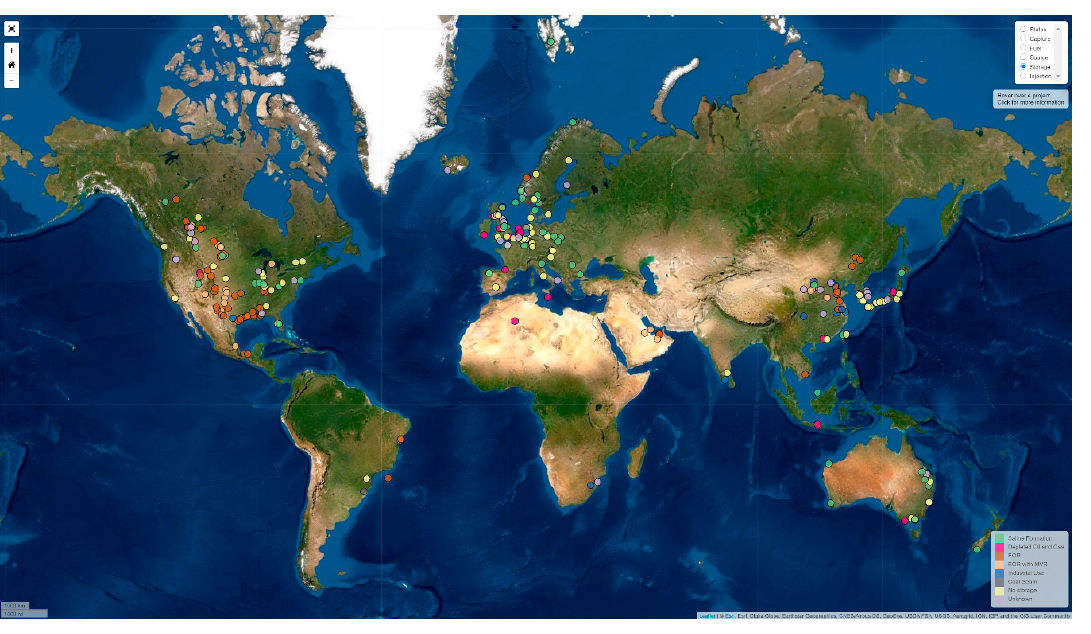
Figure 1. Location of planned or operational storage sites for carbon capture and storage (CCS) worldwide according to the Scottish Carbon Capture and Storage research group (SCCS) [17].